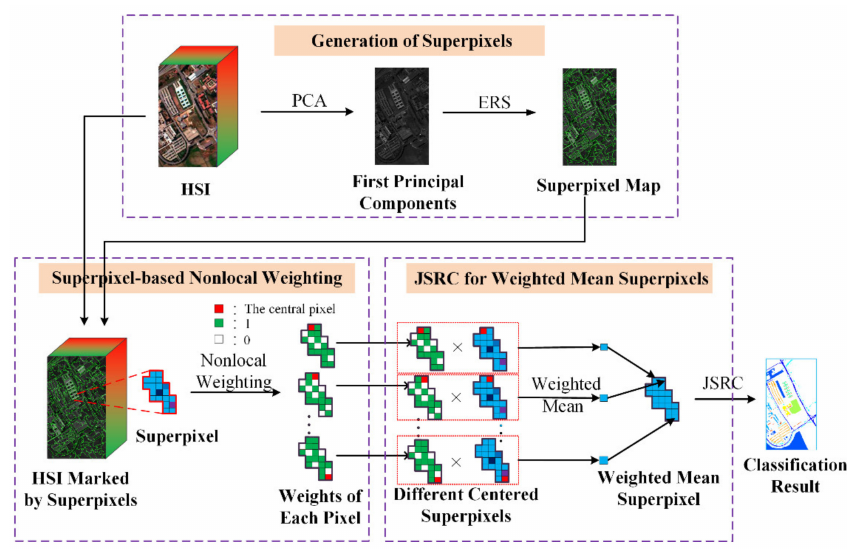
Figure 2. The workflow of the proposed SNLW-JSRC.